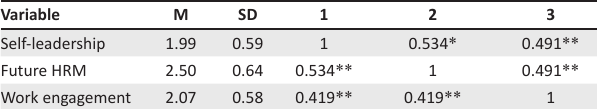
TABLE 3 : Means, standard deviations and correlations of all variables. TABLE 2 : Scale